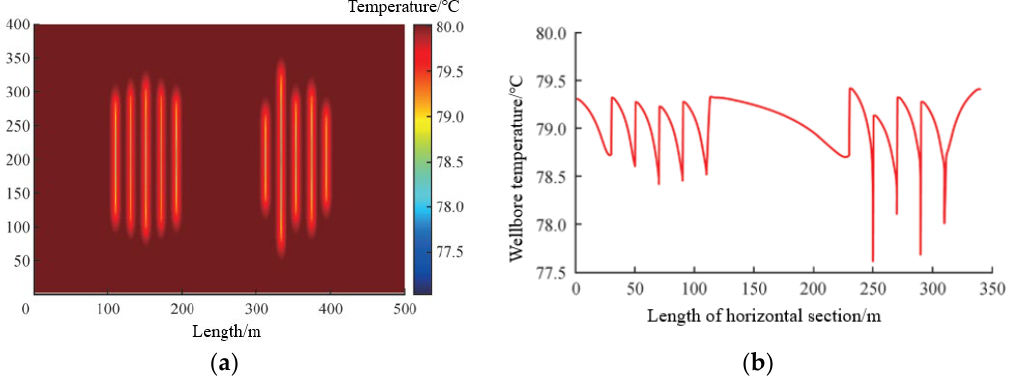
Figure 7. ( a ) Temperature distribution of horizontal wells in shale-gas reservoirs [33]; ( b ) Wellbore temperature profiles for horizontal wells in shale-gas reservoirs [33].